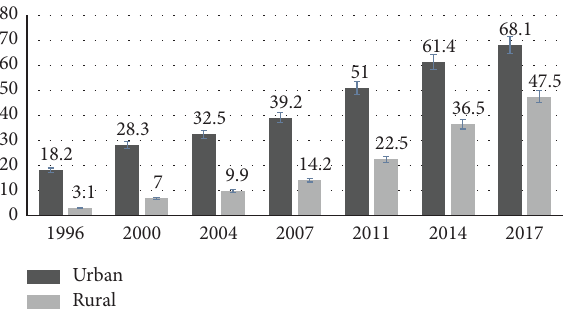
Figure 1: Percentage of received SBAs among urban and rural from